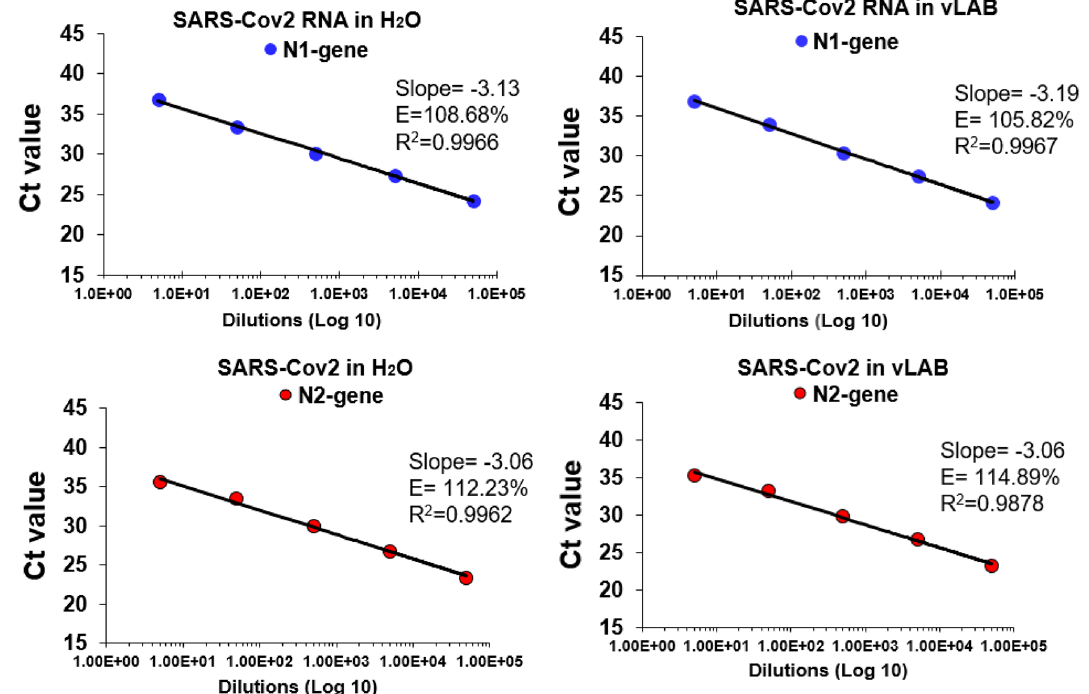
Figure 1. PCR efficiency of SARS-CoV-2 RNA in vLAB. PCR efficiency (E) for N1 and N2 gene was assessed using a duplicate tenfold dilution series of SARS-CoV-2 viral RNA. Linear regression was performed to obtain the slope and R2. The percentage efficiency was calculated from the slope using the formula E = 100 × (− 1 + 10 − 1/slope). vLAB virus Lysis Amplification